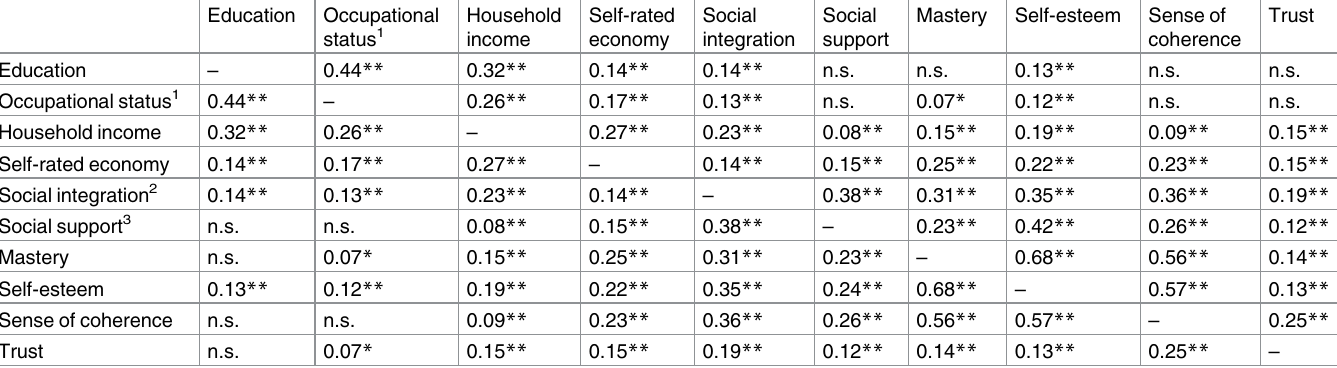
Table 3. Intercorrelation matrix for measuresof socioeconomic status and psychosocial